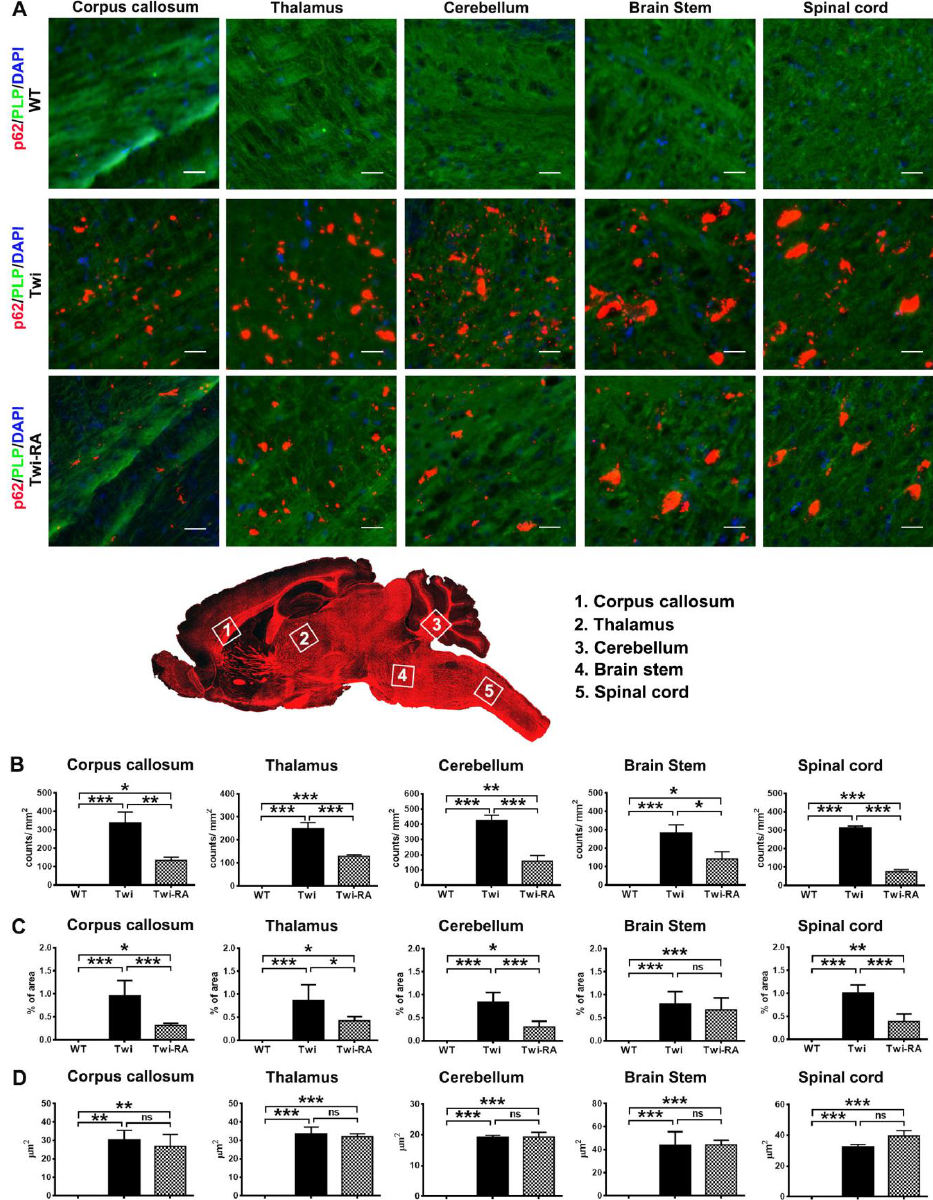
Figure 3. Total particles of p62 aggregates alleviated by rapamycin. ( A ) Representative images of p62 (red), PLP (green), and nuclei (DAPI) immunostaining in different regions of the brain of wild-type (WT), untreated twitcher (Twi), and rapamycin-treated twitcher (Twi-RA) mice at 35 days of age. Scale bars: 200 µ m. Total amounts of p62 aggregates per square millimeters ( B ), the percentage of area occupied by p62 aggregates ( C ), and the average size of p62 aggregates ( D ) were quantitatively analyzed with ImageJ. Values are expressed as mean ± SEM and compared using One way ANOVA (Tukey post hoc test) ( n = 5). Statistical significance, * p < 0.05, ** p < 0.01, *** p < 0.001, and ns (not